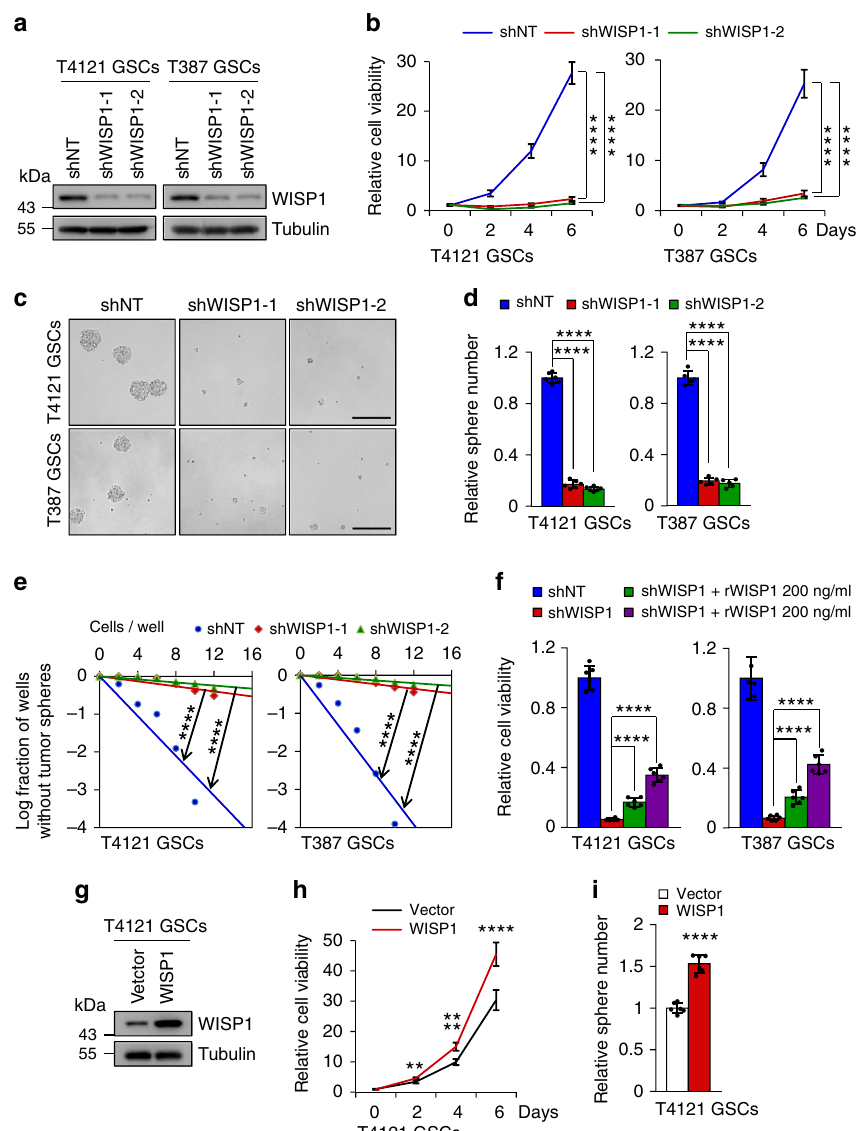
Fig. 2 WISP1 is required for GSC proliferation and self-renewal. a Immunoblot analysis of WISP1 expression in GSCs transduced with non-targeting shRNA (shNT) or WISP1 shRNA (shWISP1) through lentiviral infection. b Cell viability assay of GSCs transduced with shNT or shWISP1. n = 6 (T4121 GSCs) or 5 (T387 GSCs) biological independent samples. Data are shown as means ± s.d. **** p <0.0001, two way ANOVA analysis followed by Tukey ’ s multiple test. c Representative tumorsphere images of GSCs transduced with shNT or shWISP1. Scale Bar: 200 μ M. d Quanti fi cation of tumorspheres formed by GSCs transduced with shNT or shWISP1. n = 6 (T4121 GSCs) or 5 (T387 GSCs) biological independent cell cultures. Data are shown as means ± s.d. **** p <0.0001, two-tailed unpaired t -test. e In vitro extreme limiting dilution analysis of the tumorsphere formations of GSCs expressing shNT or shWISP1. n = 30 biological independent cell cultures. **** p <0.0001 by ELDA analysis. f Cell viability assay of GSCs transduced with shNT or shWISP1 and cultured with different dose of recombinant human WISP1 (rWISP1) protein for 4 days. n = 6 biological independent samples. Data are represented as means ± s.d. **** p <0.0001, two-tailed unpaired t -test. g Immunoblot analysis of WISP1 expression in T4121 GSCs after transduction with WISP1 overexpression or vector control. h Cell viability assay of T4121 GSCs transduced with WISP1 overexpression or vector control. n = 6 biological independent samples. Data are represented as means ± s.d. ** p = 0.0014, **** p <0.0001, two-tailed unpaired t -test. i Tumorsphere formation of T4121 GSCs transduced with WISP1 overexpression or vector control. n = 6 biological independent cell cultures. Data are shown as means± s.d. **** p <0.0001, two-tailed unpaired t -test. Source data are provided as a Source data fi le.